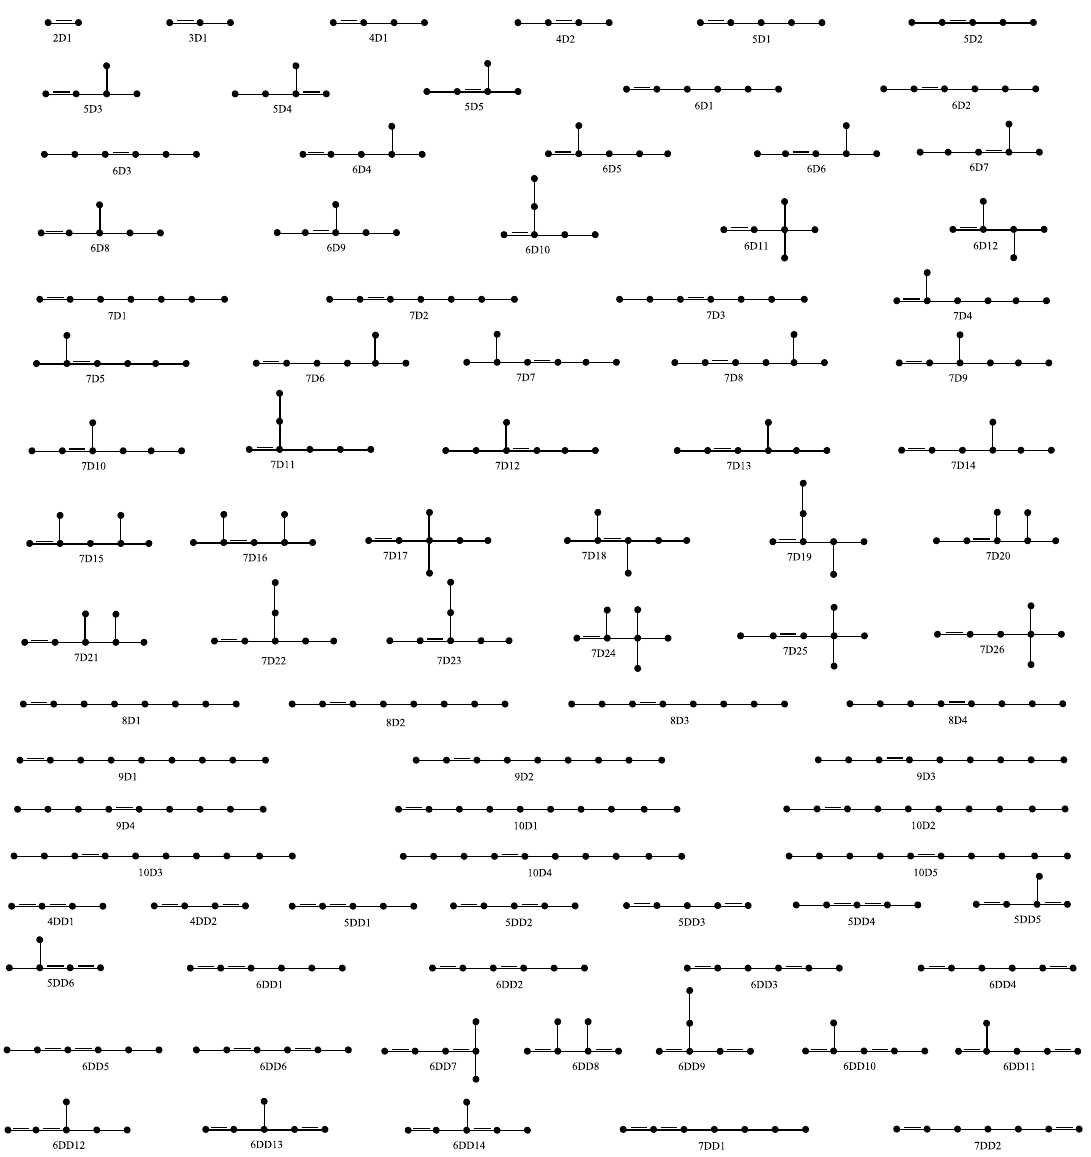
Figure 1. Graphs of considered molecules with theirs